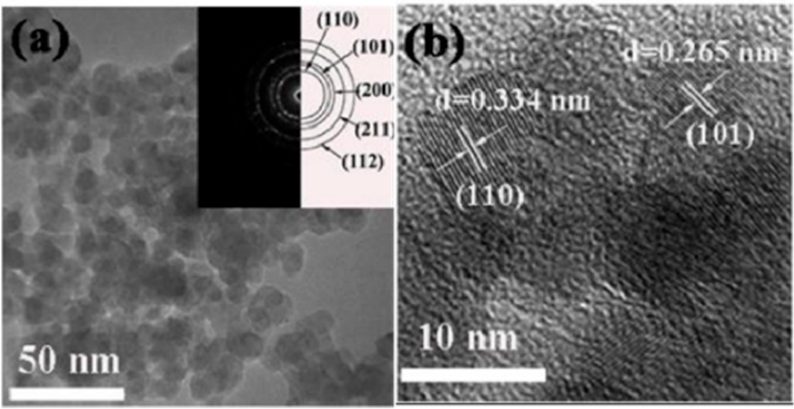
Figure 9. ( a ) TEM images of 0.45 at% SnO 2 : Ho 3+ nanoparticles. The inset is the SAED image of 0.45 at% SnO 2 : Ho 3+ nanoparticles. ( b ) The HRTEM image of 0.45 at% SnO 2 : Ho 3+ nanoparticles [88].